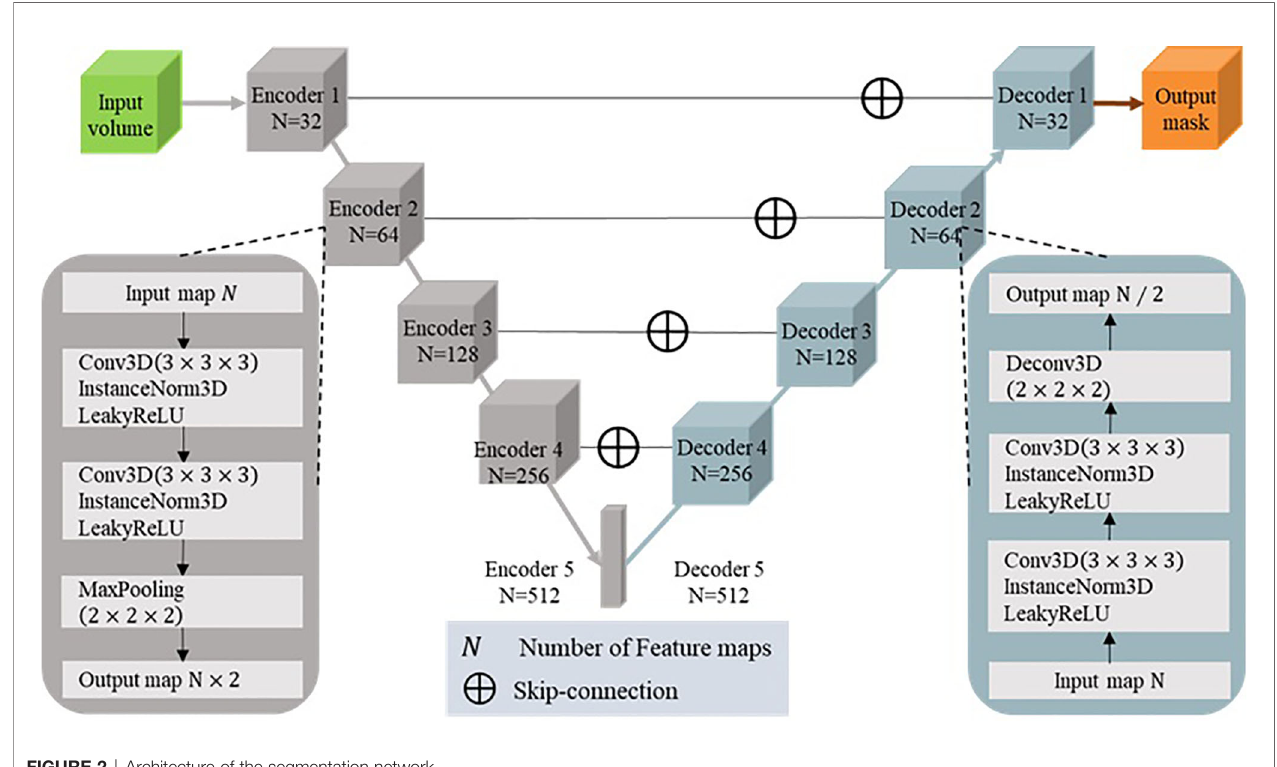
FIGURE 2 | Architecture of the segmentation